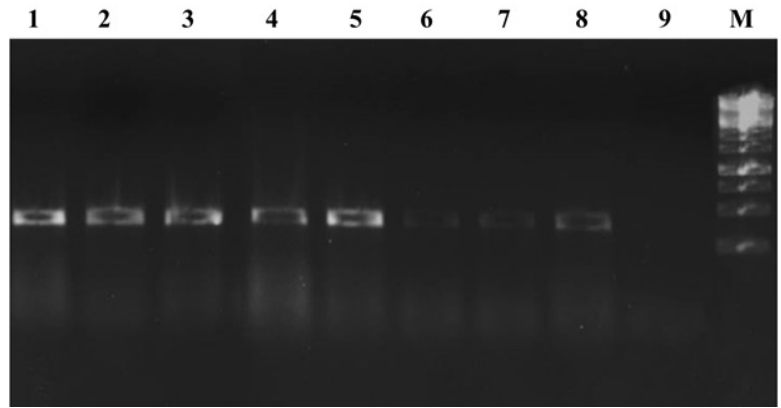
Fig. 5. Agarose gel electrophoresis showing sensitivity of IC-PCR. Lane 1 to 9- Sensitivity from 10 9 -10 1 , M- 1kb DNA